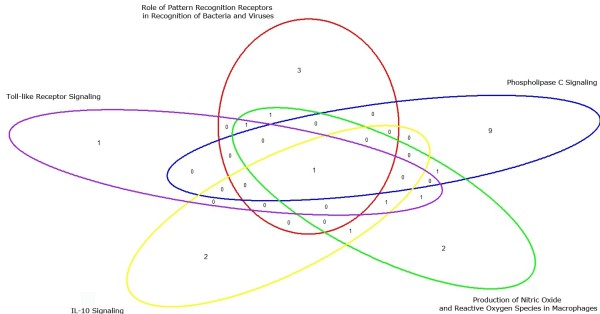
Venn diagram of the meta-analysis results. Venn diagram illustrating one gene in common (NFKB1) among the five pathways and distinct genes for the meta-analysis (red: 3 genes of role of pattern recognition receptors in recognition of bacteria and viruses; blue: 9 genes of phospholipase C signalling; green: 2 genes of production of nitric oxide and reactive oxygen species in macrophages; yellow: 2 genes of IL-10 signalling; purple: one gene of toll like receptor signalling).